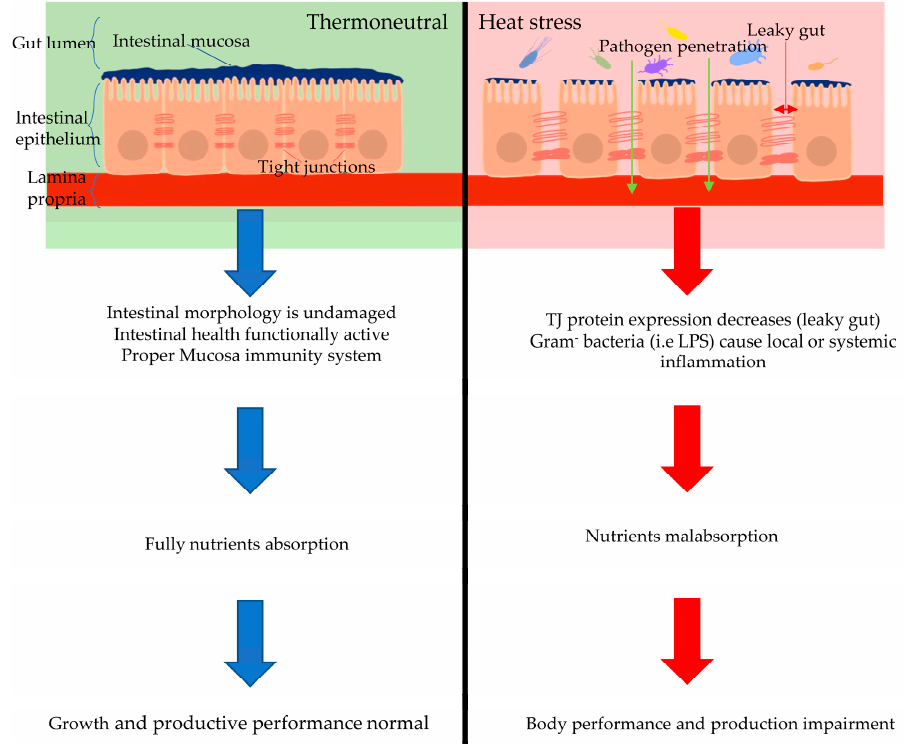
Figure 2. Effect of heat stress on intestinal health and immune system.